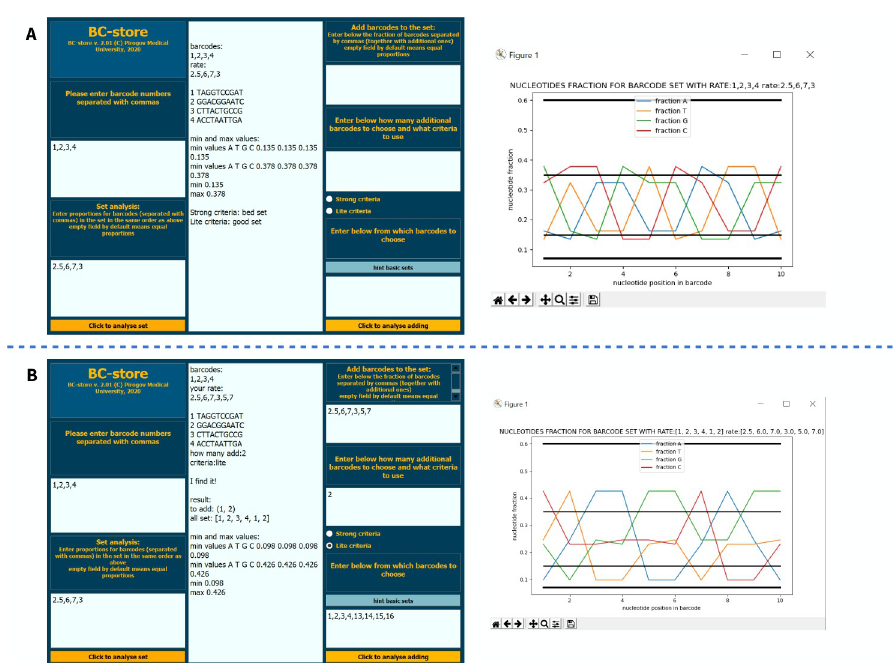
Fig 13. A–an example of how BC-store works in case of equal proportions of barcodes in a set. In the case of equal proportions, the field for entering shares should be left free. B–an example of how BC-store works if the other barcodes are added to the